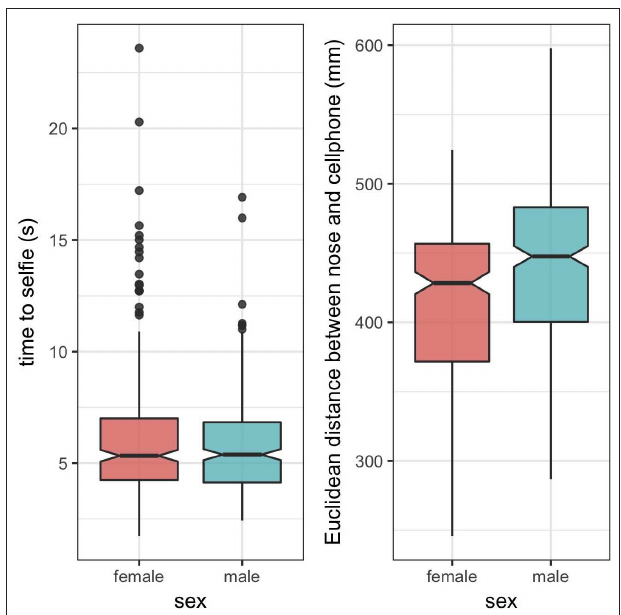
FIGURE 7 | Left: Most selfies by both female and male participants were taken in 4–7s; selfies taken in more than 10s were relatively rare. Right: females tended to keep the smartphone closer to their nose than did